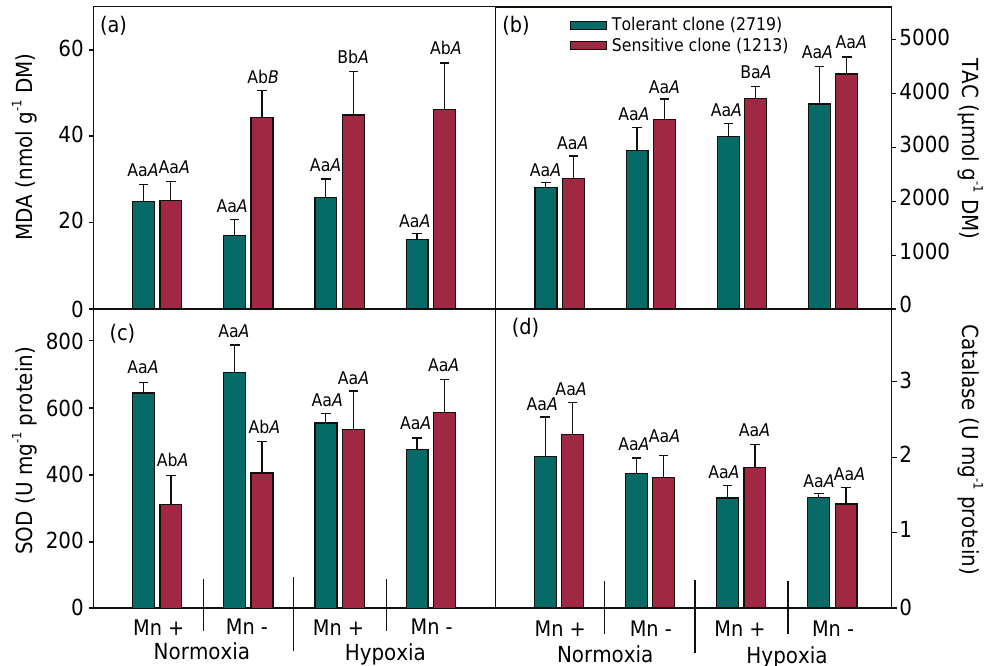
Figure 4. Enzymatic activity and metabolites in leaves from two Eucalyptus clones in hydroponics in response to the treatments. Level of malondialdehyde (a); total antioxidant capacity (b); superoxide dismutase activity (c); and catalase activity (d). Uppercase letters compare the effect of O 2 (normoxia: 8 mg L -1 and hypoxia: 4 mg L -1 ) for the same clone and the same Mn concentration. Lowercase letters compare the effect of clones (tolerant and sensitive to VRDSD) for the same concentrations of Mn and O 2 . Uppercase italic letters compare the effect of the Mn concentration of the nutrient solution (300 and 1.39 mg L -1 ) for the same clone and the same O 2 concentration. Equal letters do not differ statistically at the level of 5